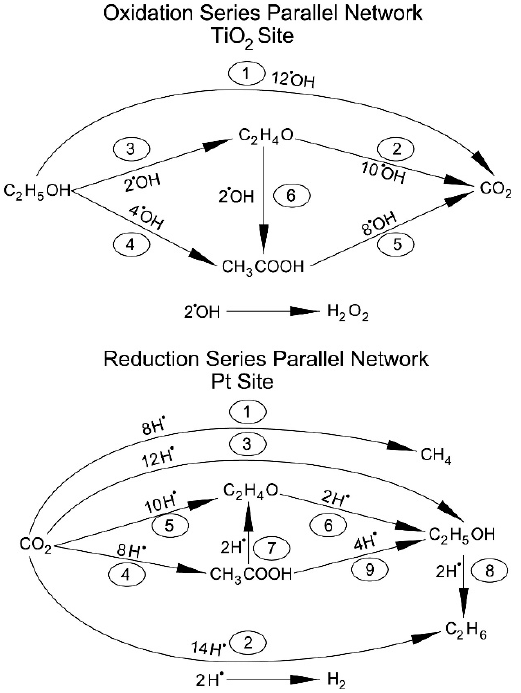
Figure 12. Oxidation–reduction network promoted by TiO 2 and Pt sites in the Pt–TiO 2 photocatalysts.